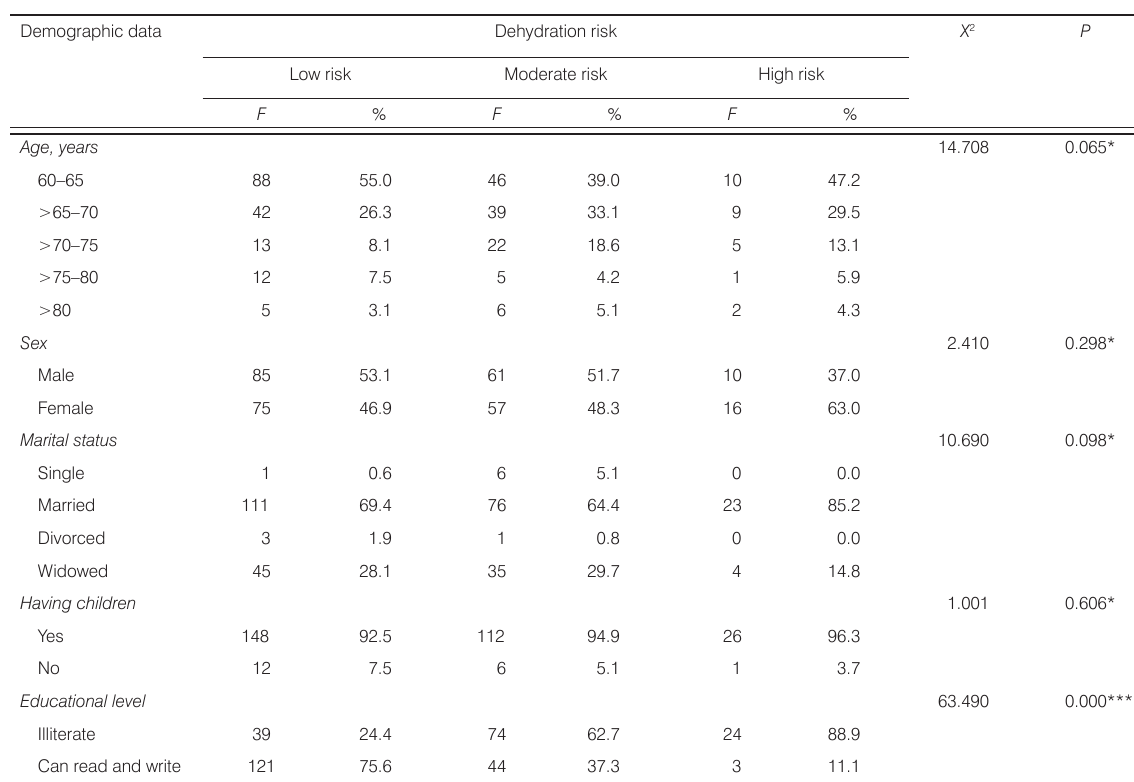
Table 5. Correlation between the type of medication and risk for dehydration (N =